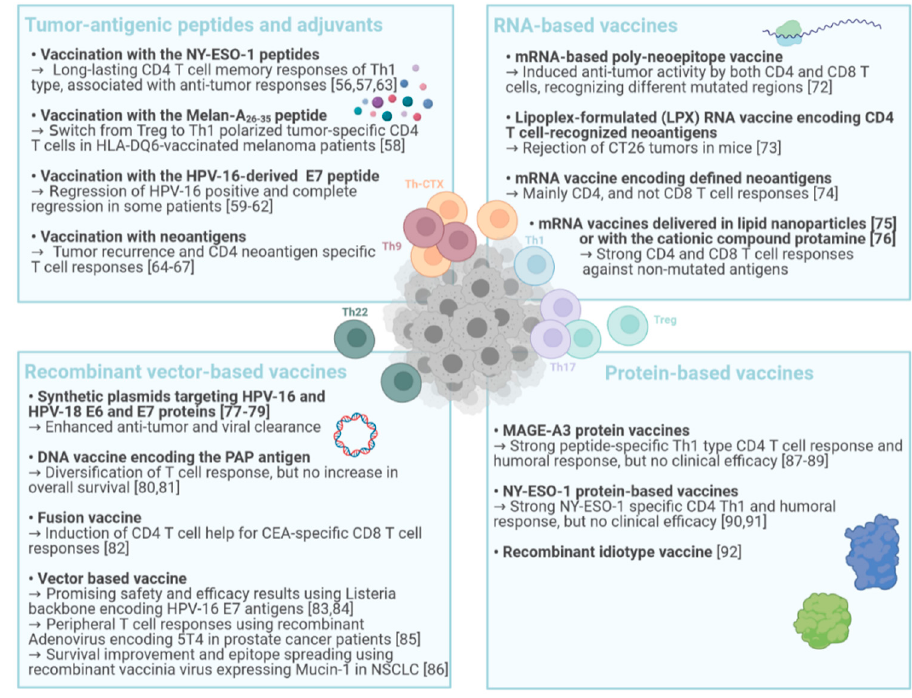
Figure 2. Summary of vaccination strategies and their impacts on CD4 T cell responses.